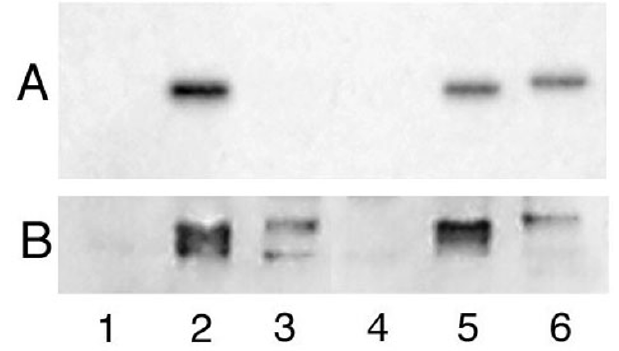
Figure 6 Myristoylation and palmitoylation of α COS-7 cells were transfected with pcDNA3 (lanes 1 and 4), or pcDNA3 containing α i2 (lanes 2 and 5) or s α i2 (lanes 3 and 6). 48 h after transfection, cells were incubated with 1.0 mCi/ml 3 H-palmitate (lanes 1–3) or 0.5 mCi/ml 3 H-myristate (lanes 4–6) for 2 h. Following immunoprecitation with the EE antibody, duplicate samples were resolved by